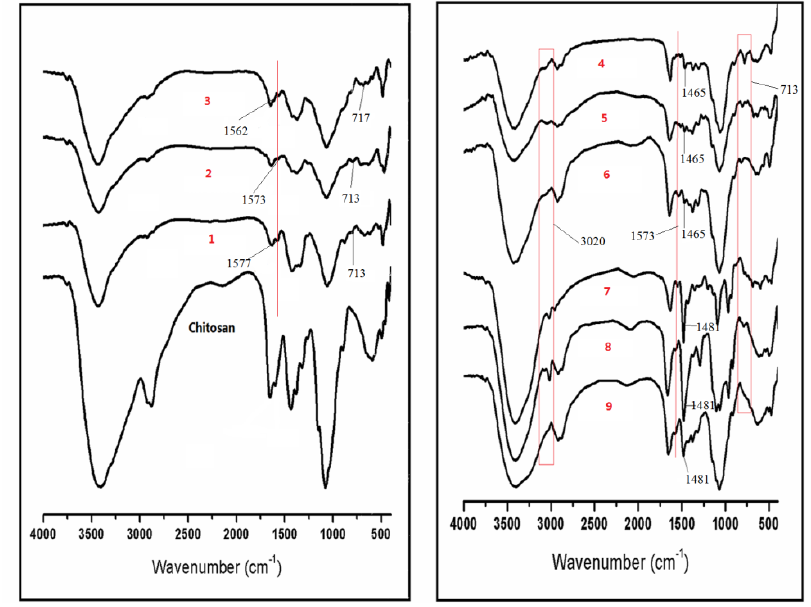
Figure 1. FT-IR spectra of chitosan and chitosan derivatives.